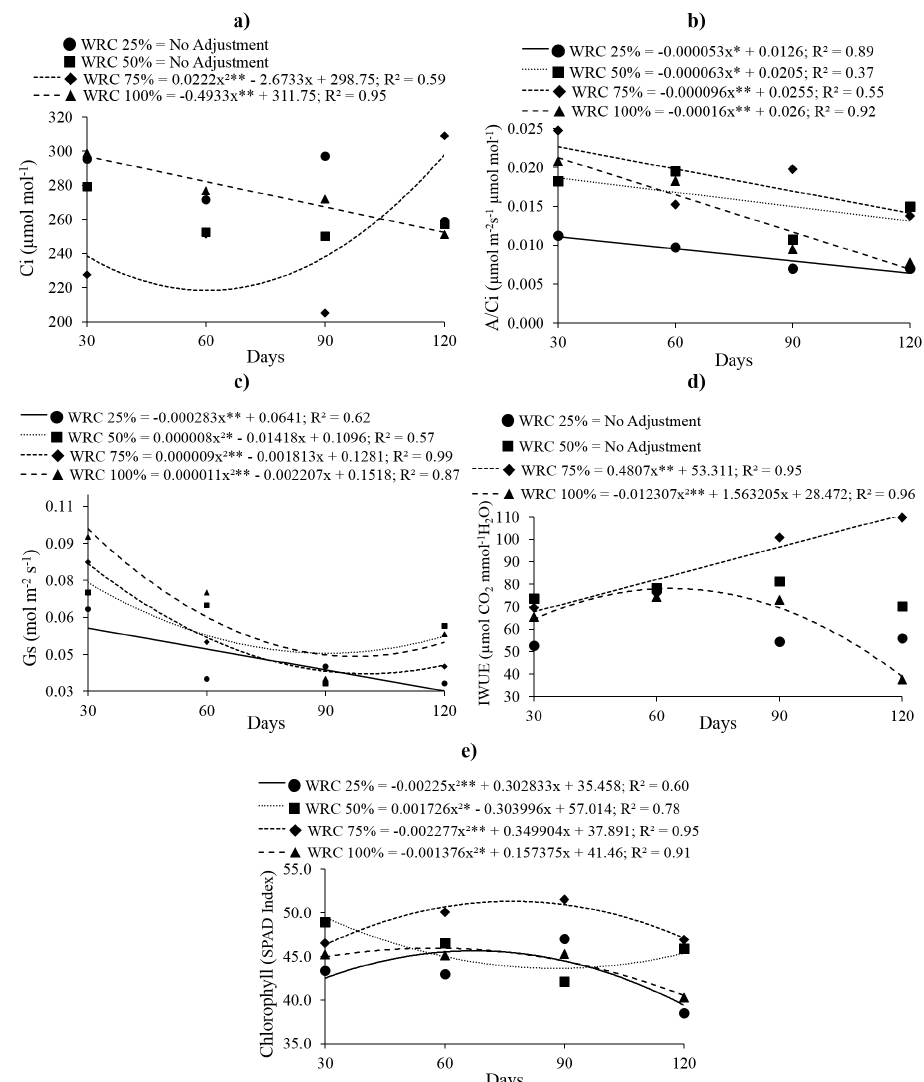
Figure 3 - Internal carbon dioxide gas - Ci ( a ), Carboxylation efficiency of rubisco - A/Ci ( b ); Stomatal conductance - gs ( c ), intrinsic water use efficiency - IWUE ( d ) and Chlorophyll ( e ) in Copaifera langsdorffii Desf. depending on different water retention capacity (WRC) and